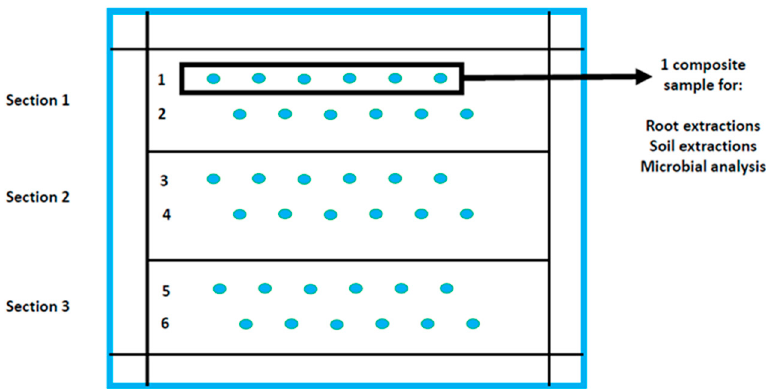
Figure 2. Sampling strategy at each of the 15 soybean localities sampled during the 2019 growing season for nematode and microbe analyses (Illustration: Gerhard Engelbrecht, North-West University). Each field therefore had a total of 6 composite root and soil samples that were analyzed.